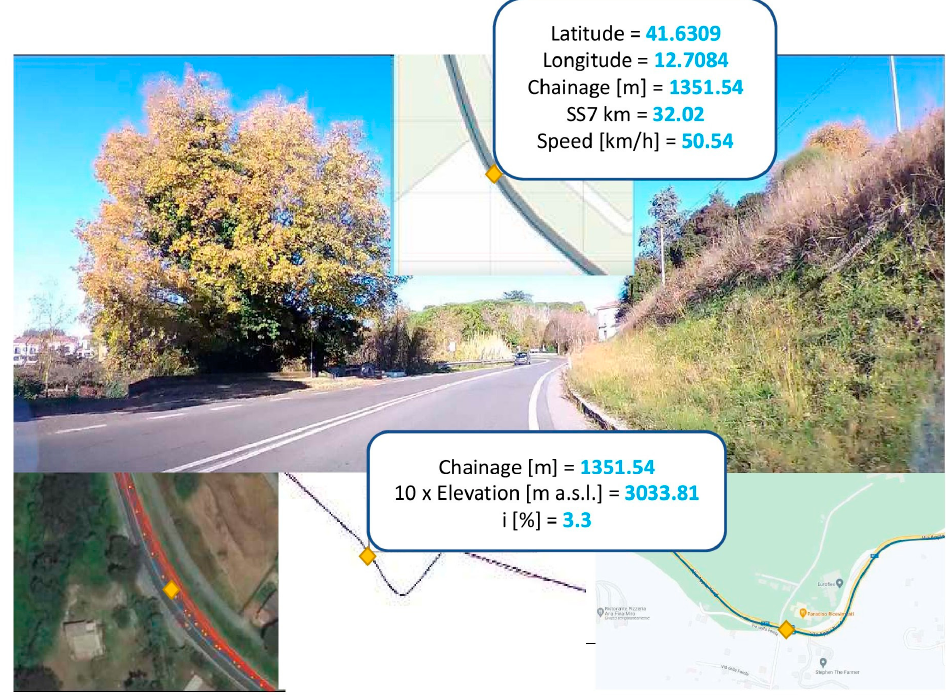
Figure 3. Videos synchronization to conduct the inspections.